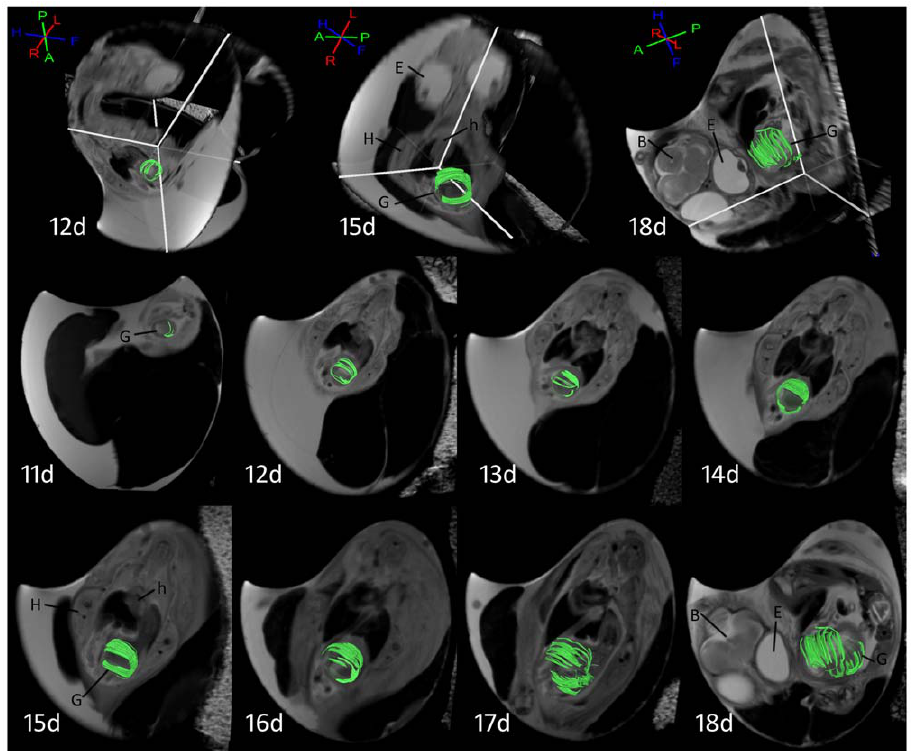
Figure 2. Serial smooth muscle fiber tracking result of embryonic gizzard from day 11 to day 18 of incubation. 3D images for days 12, 15, 18, with 3D axes provided in the upper left corner for orientation ( H: head, F: foot, R: right, L: left, P: posterior, A: anterior). Key : B : brain, E : eye, G : gizzard, H : hind limb, h: heart.